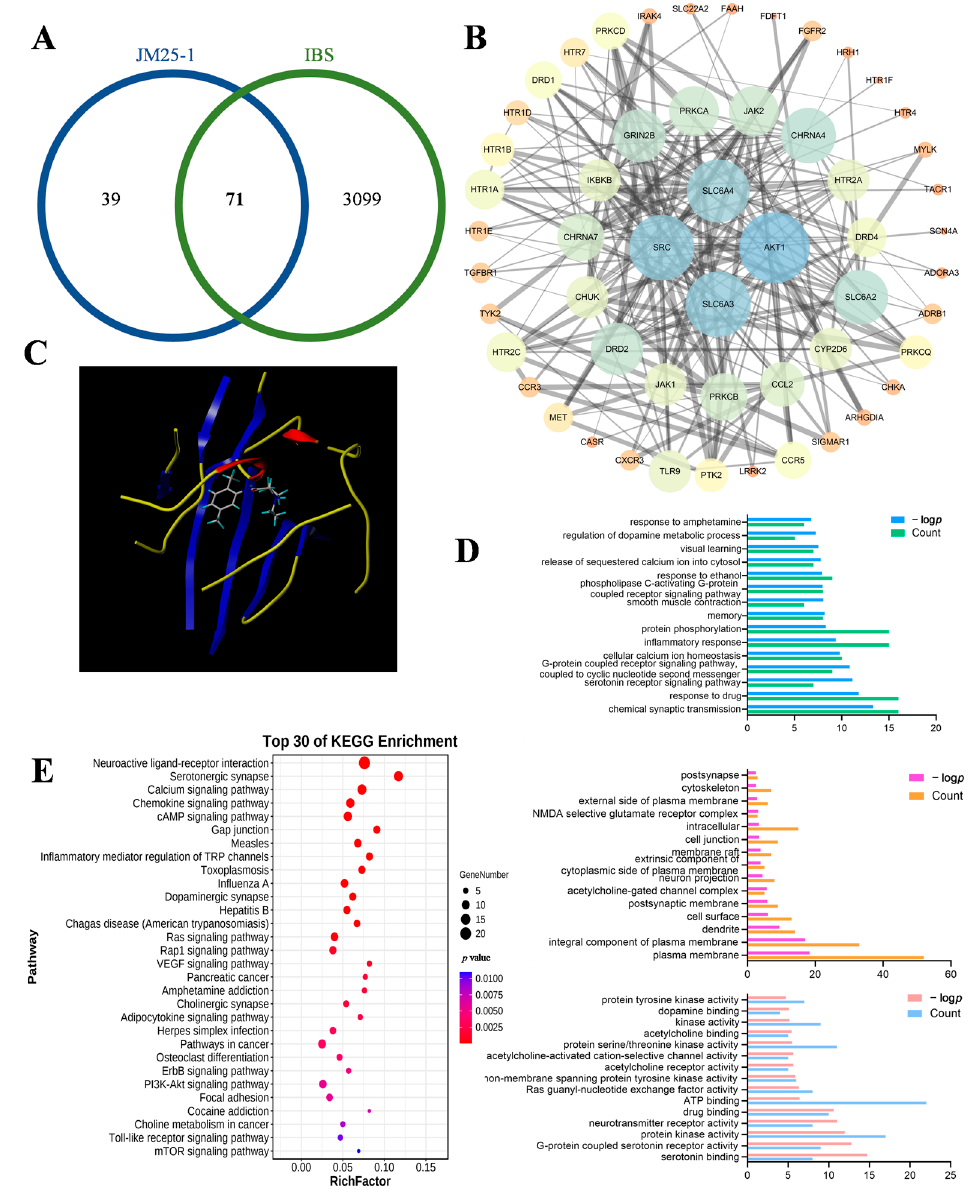
Figure 6. The effect of JM25-1 on IBS was discussed based on network pharmacology. ( A ) Venn diagram of JM25-1 targets and IBS targets. ( B ) Protein–protein interaction (PPI) network of bioactive compounds of JM25-1 against IBS. ( C ) Visualization of molecular docking between JM25-1 and IBS. ( D ) GO enrichment analysis of core target for JM25-1 against IBS, including biological process, cellular components and molecular function. ( E ) Top 30 enriched KEGG pathways of core target for JM25-1 against IBS. The color scales indicate the different thresholds of adjusted p -values, and the sizes of the dots represent the gene count of each term.